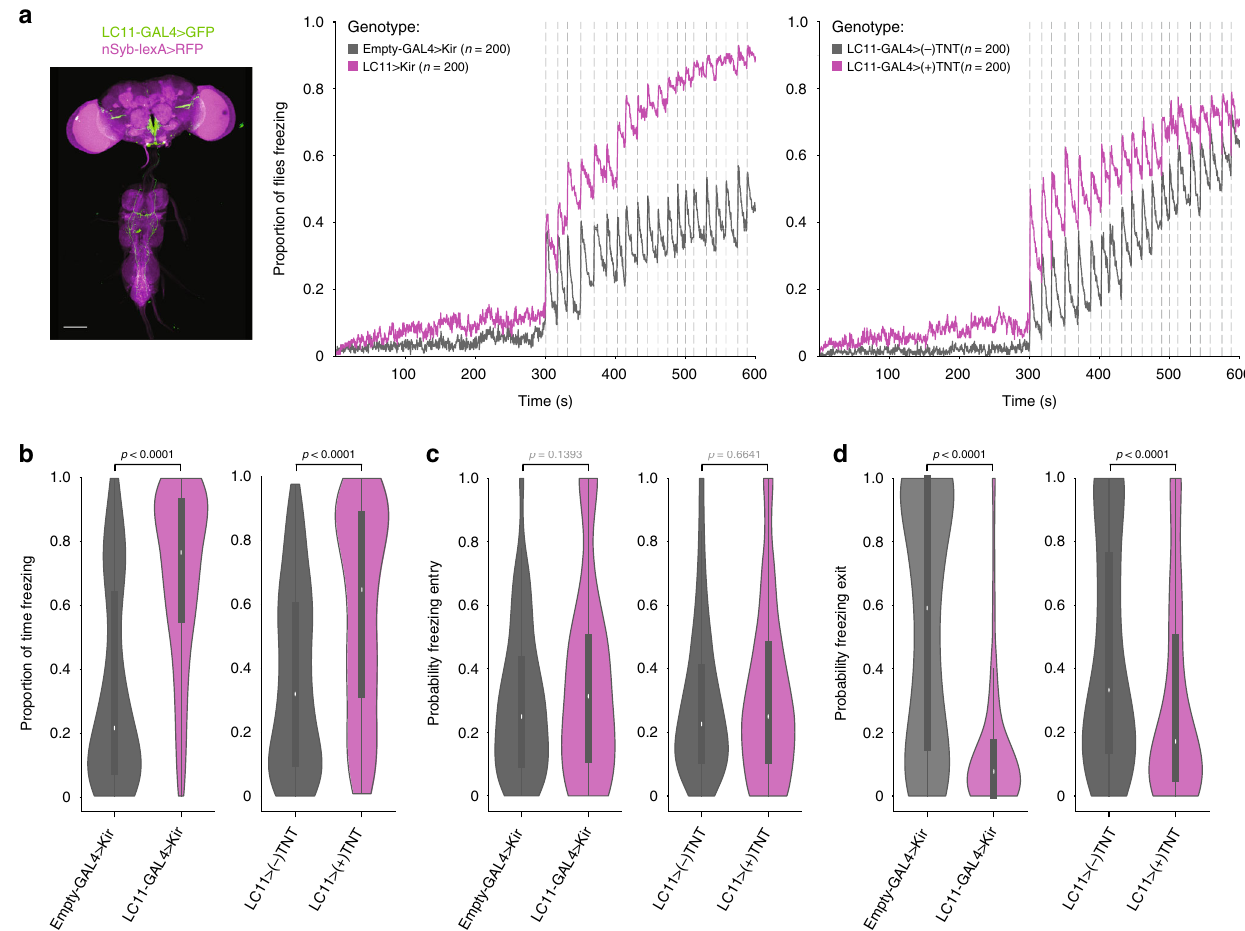
Fig. 5 Manipulating lobula columnar neurons 11 (LC11). a Anatomy (scale bar, 100 μ m) and proportion of fl ies freezing throughout the experiment in groups of fi ve, for LC11 - GAL4 > Kir2.1 and LC11-GAL4 > ( + ) TNT depicted in purple and controls (gray). b – d Violin plots representing the probability density distribution of individual fl y data bound to the range of possible values, with boxplots (elements: center line, median; box limits, upper (75) and lower (25) quartiles; and whiskers, 1.5× interquartile range). b Proportion of time spent freezing throughout the experiment. c Probability of freezing entry after looming presentation. d Probability of freezing exit before the following looming stimulus. P -values result from two-tailed Mann – Whitney